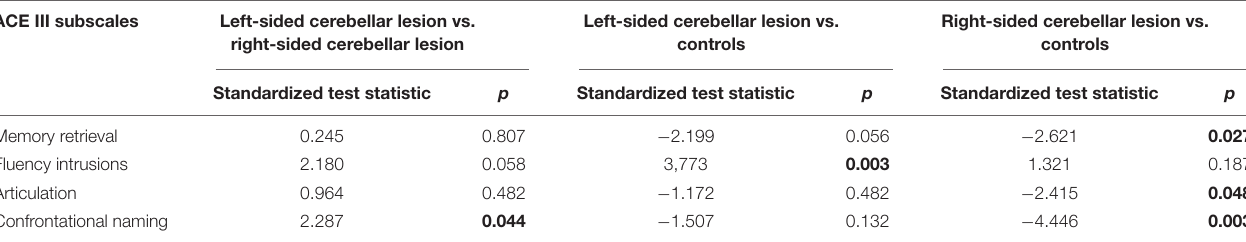
TABLE 5 | Pairwise comparisons in memory, fluency, and language subscale scores between patients with left-sided cerebellar lesions, patients with right-sided cerebellar lesions, and controls. ACE III subscales Left-sided cerebellar lesion vs. Left-sided cerebellar lesion vs. Right-sided cerebellar lesion vs. right-sided cerebellar lesion controls